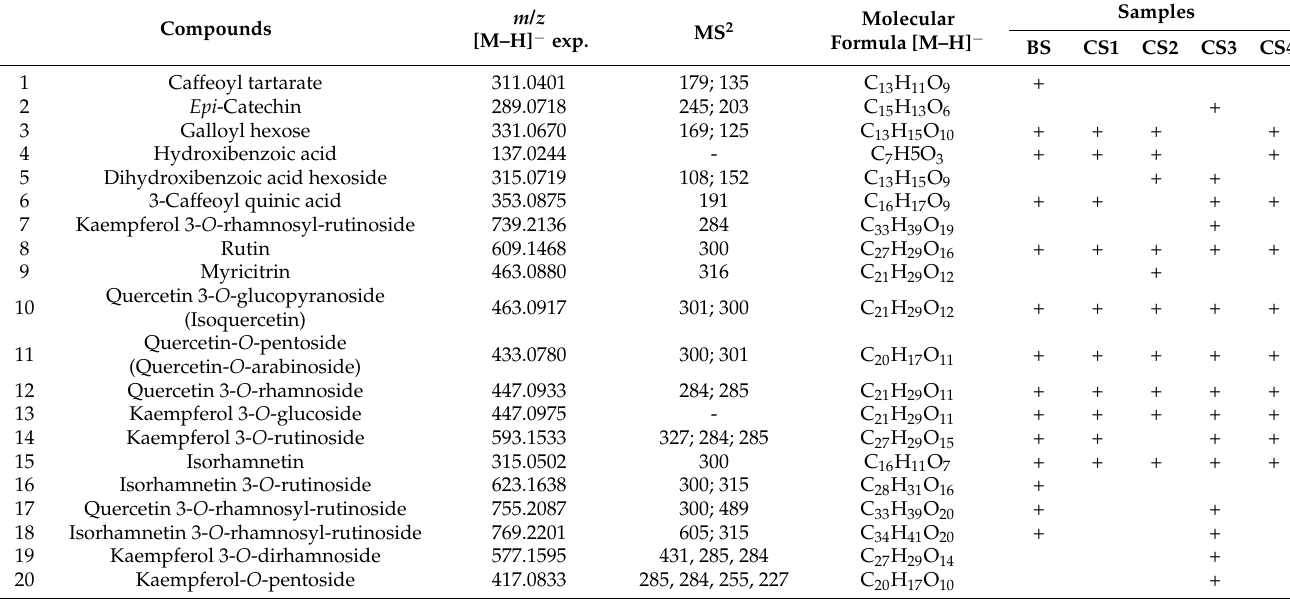
Table 2. Tentatively identified compounds of B. forficata